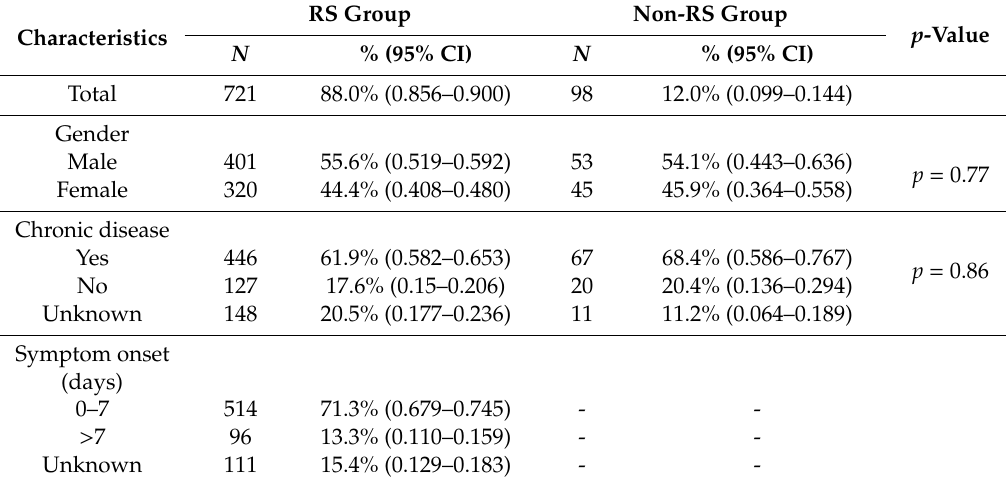
Table 2. Comparison of demographic and clinical characteristics of patients admitted to the Emergency Department with (RS group) and without (Non-RS group) respiratory